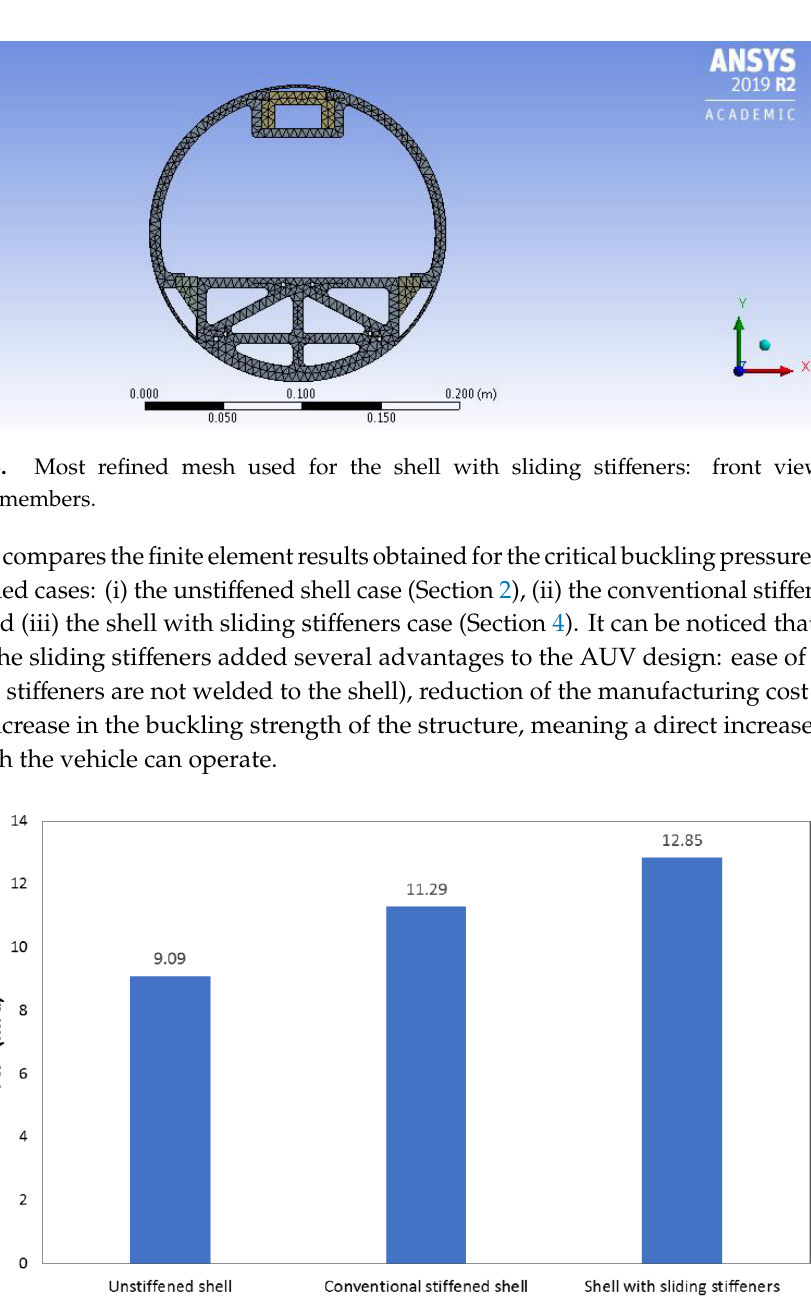
Figure 15. Most refined mesh used for the shell with sliding stiffeners.